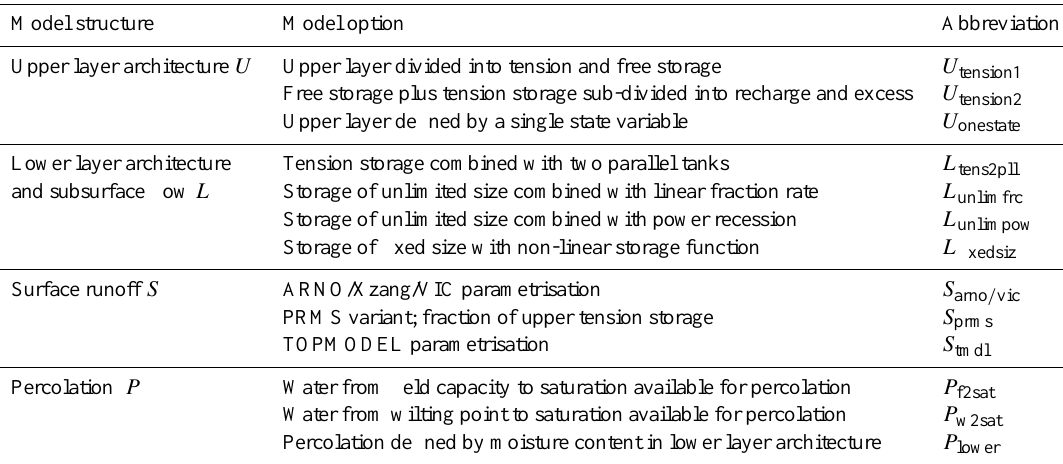
Table 1. FUSE model decision